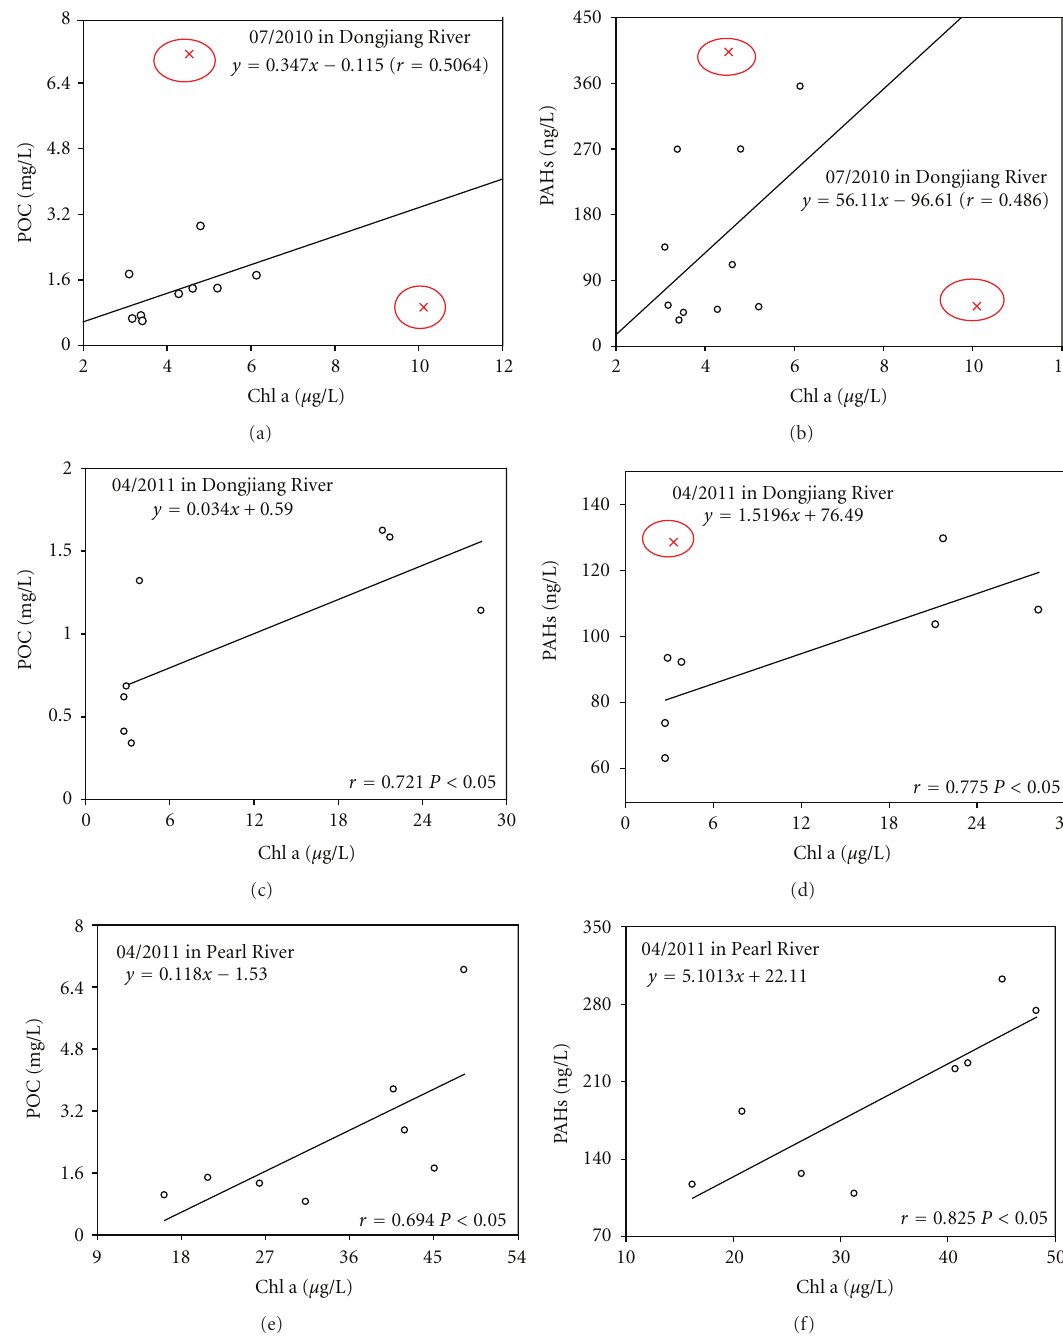
Figure 3: Relationship between Chl a and POC and between particulate PAHs (S-PAHs) and Chl a. It was found that PAHs in SPM was higher in Pearl River than in Dongjiang River in